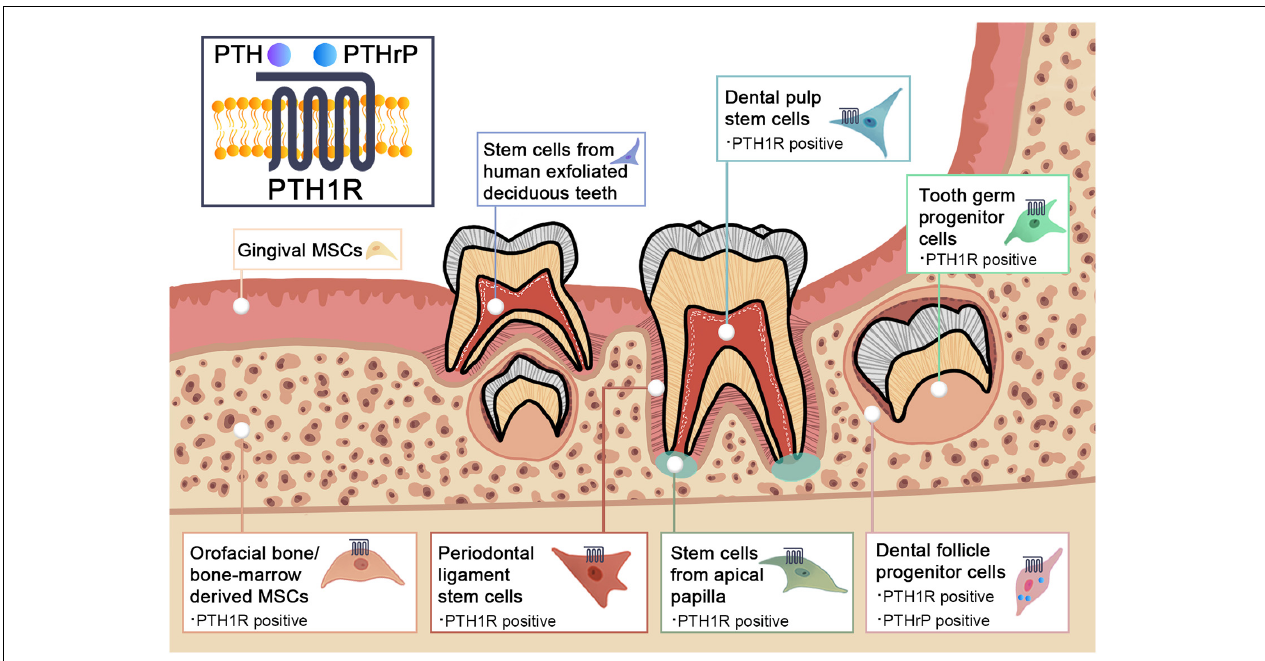
FIGURE 1 | Schematic graph illustrating the PTH1R signaling in dental mesenchymal stem cell